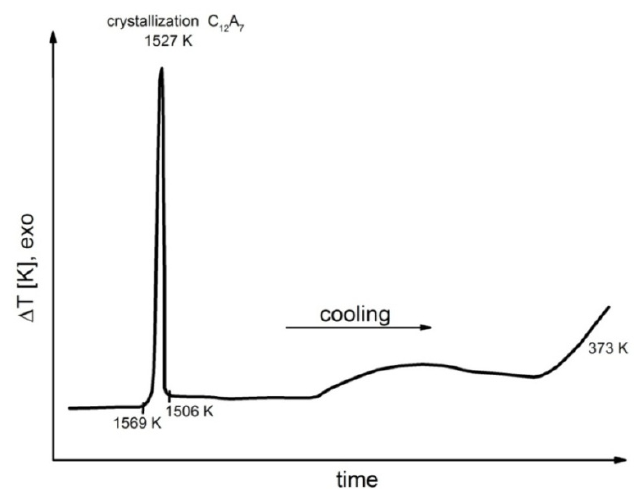
Figure 9. Thermogram recorded for sample 7 during the cooling process.